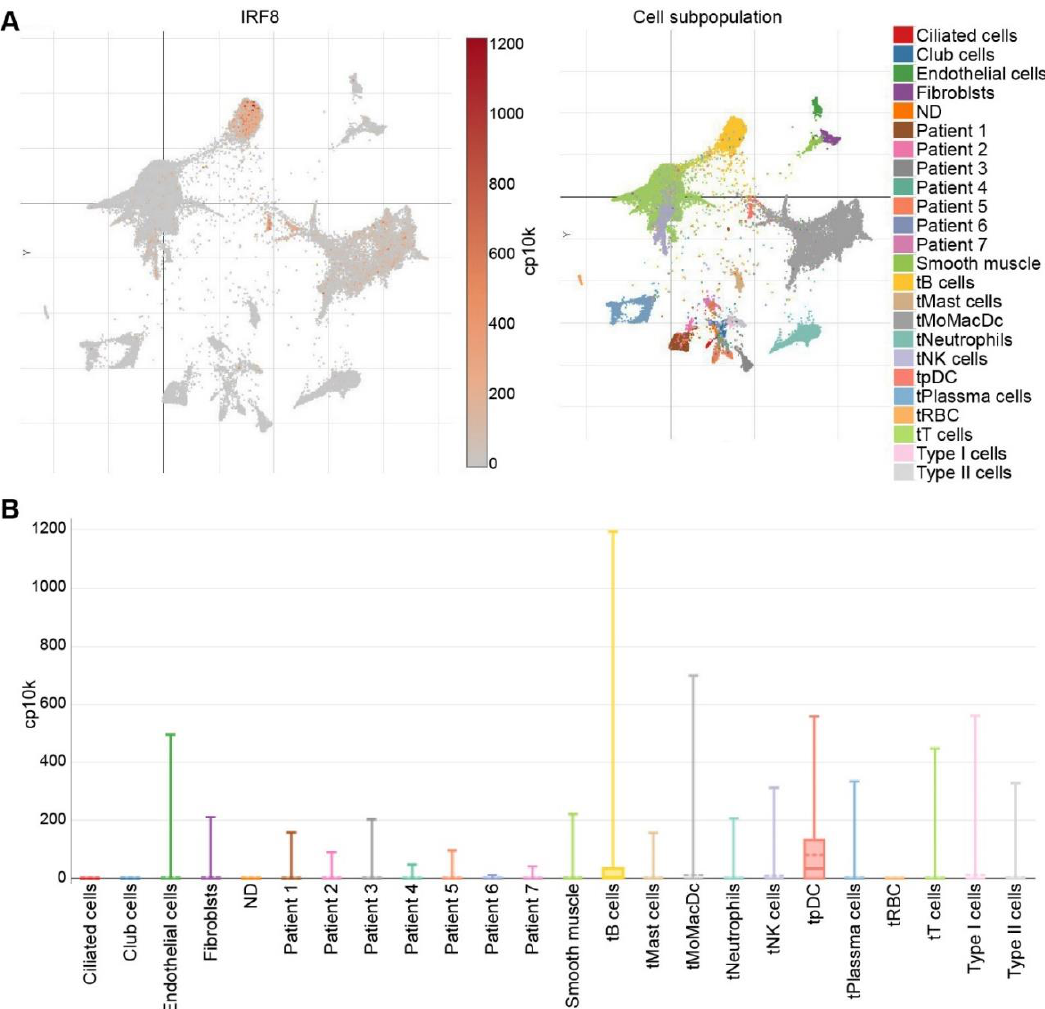
Figure 4. IRF8 expression profiles in human lung cancer in the single cell level. ( A ). scRNA-Seq datasets were extracted from the lung cancer scRNA-Seq datasets in the Broad Institute Single Cell Portal. Right panel shows UMAP plot of cell subpopulations from human lung tumor. Cells are color- coded. Left panel shows UMAP plot of IRF8 expression in the respective cells as shown in the right panel. ( B ). Box plot showing IRF8 expression level in the indicated cells and tumor (Patients 1–7). t: